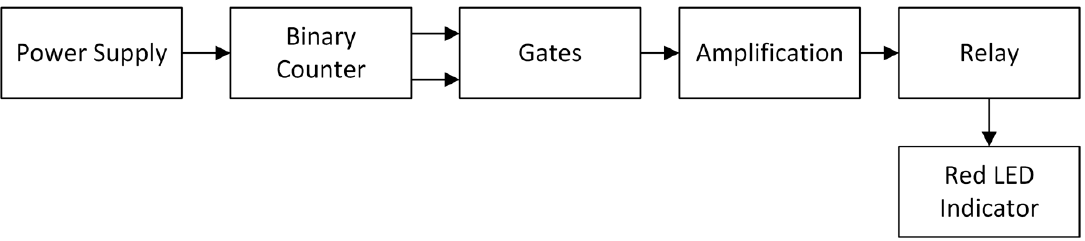
Figure 2. Block diagram of FHRS .